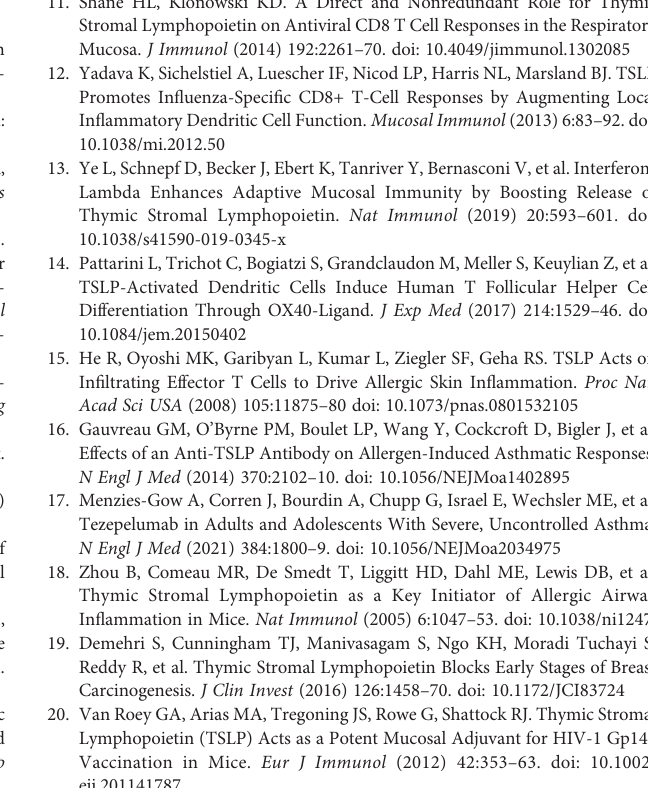
infected with (A) 40 PFU or (B) 100 PFU of in fl uenza virus PR8. Weight loss and survival were monitored for 14 days. Mice were sacri fi ced when having lost 25% of their original body weight. Data are representative of two independent experiments and shown as mean ± SD. Supplementary Figure 2 | TSLPR de fi ciency impairs migration of DCs and restrains GC reaction in the spleen of mice infected with live-attenuated in fl uenza virus. (A) B6-WT (n = 5) and Tslpr – / – mice (n = 5) were intranasally infected with live- attenuated in fl uenza virus (hvPR8- D NS1), and the frequency of CD103 + DCs among live CD11c + MHC-II + immune cells in the spleen were determined at day 5 post-infection. (B, C) B6-WT (n = 5) and Tslpr – / – mice (n = 5) were intranasally infectedwith hvPR8- D NS1 and sacri fi ced onday 10post-infection. The frequencies of (B) Tfh cells among live CD19 − CD4 + CD44 + cells and ( C , upper panels) GC B cells among live CD4 - B220 + cells in spleen were determined by fl ow cytometry. ( C , lower panels) Flow cytometry analyzing the frequency of IgG1 + GC B cells among live CD4 − B220 + GL7 + Fas + cells in the spleen. Data are representative of three independent experiments and shown as mean ± SEM. Each symbol represents the result from an individual animal. **P < 0.01, ***P < 0.001 by unpaired two-tailed Student ’ s t-test. Supplementary Figure 3 | TSLPR de fi ciency does not alter the proportions of migratory DCs and has no effect on the GC reaction in the lymph nodes and spleen. (A) The frequency of CD103 + DCs among live CD11c + MHC-II + immune cells from lymph nodes and spleen was determined in naïve B6-WT (n = 6) and Tslpr – / – mice (n = 5). (B, C) B6-WT (n = 6) and Tslpr – / – mice (n = 5) were sacri fi ced, and the frequencies of (B) Tfh cells among live CD19 − CD4 + CD44 + cells and (C) GC B cells among live CD4 - B220 + cells in lymph nodes and spleen were determined by fl ow cytometry. Data are representative of two independent experiments and shown as mean±SEM.Each symbolrepresents theresultfroman individualanimal.Unpaired two-tailed Student ’ s t-tests were performed to determine signi fi cant difference. NS, no signi fi cant